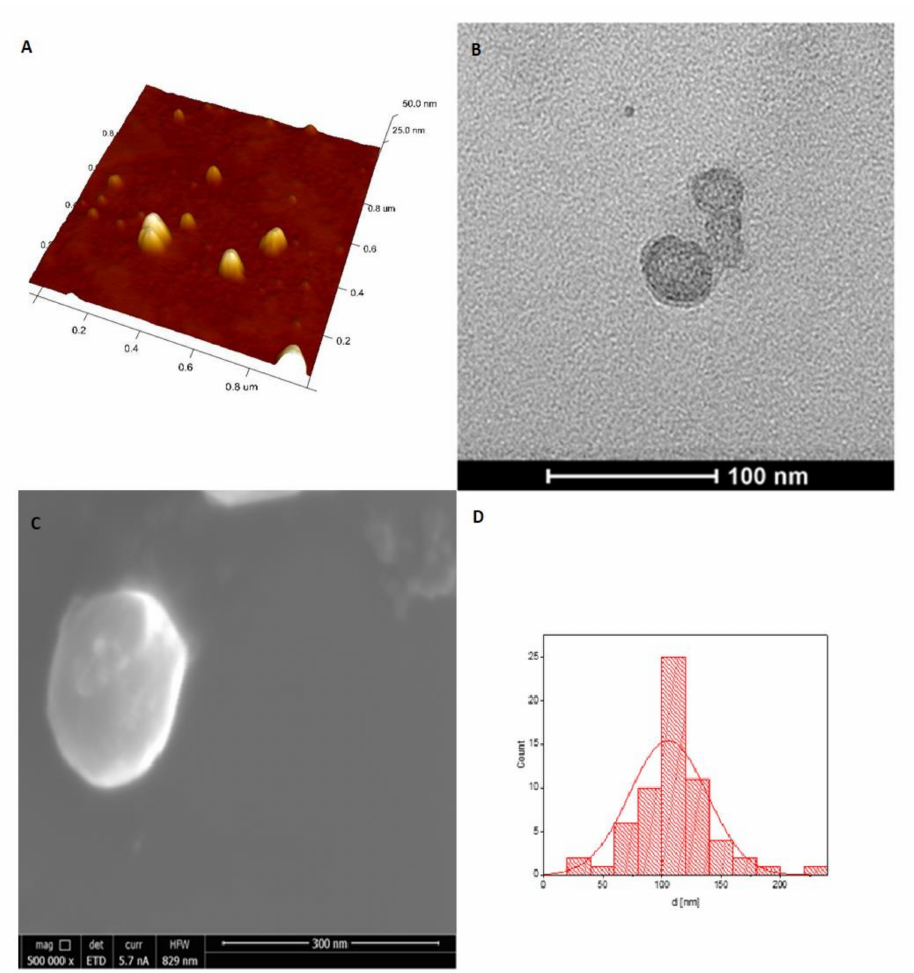
Figure 5. ( A ) Three dimensional (3D) AFM; ( B ) TEM; and ( C ) SEM images of C-PUL / DEX-A nanohydrogel structures (at C-PUL:DEX-A ratio of 4:1); ( D ) 4:1 NGs histogram obtained from SEM images (SI), fitted with a normal size